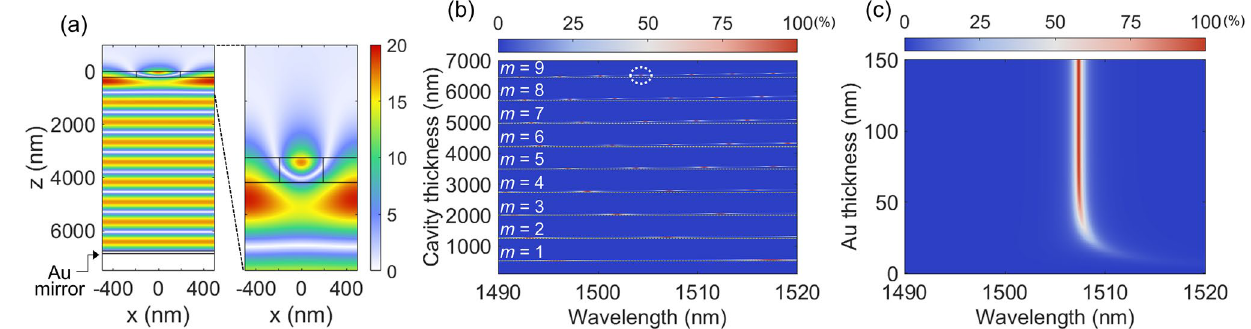
Figure 4. ( a ) |E y | field profile of the gas sensor filled with a gas of n = 1.005 excited at the resonance wavelength of 1507.39 nm. The enlarged image on the right shows the field profile near the metasurface. The black solid lines show the structure boundaries of the metasurface and the Au mirror. ( b ) Numerical result of absorption contour map as a function of wavelength and cavity thickness. The m indicates the mode number of the gas sensor. A representative mode with m = 9 around the critical coupling condition is indicated with a white dashed circle. Yellow dash lines represent parallel lines across the wavelength range. ( c ) Numerical result of absorption contour map as a function of wavelength and Au